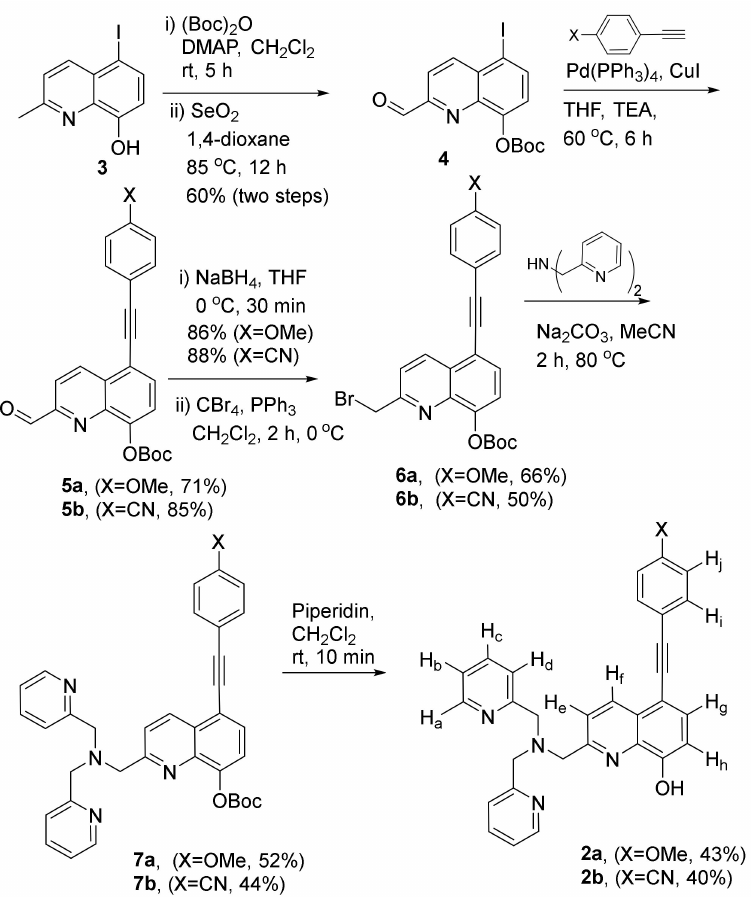
Scheme 1. Synthetic scheme for the preparation of quinoline-based tolan ( 2